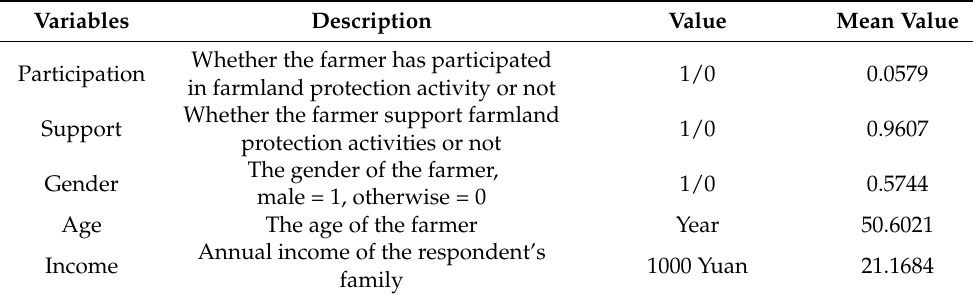
Table 3. Variable definition for farmer’s